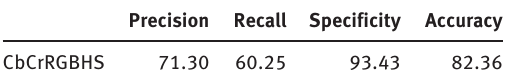
Table 6. Accuracy Results for CbCrRGBHS on the UCD Database.